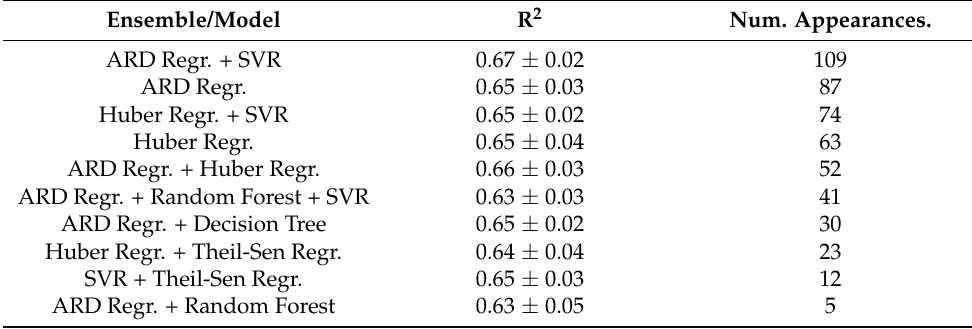
Table 9. The 10 best-performing models (ensembles and single regressors). Ensemble/Model R 2 Num. Appearances. ARD Regr. +